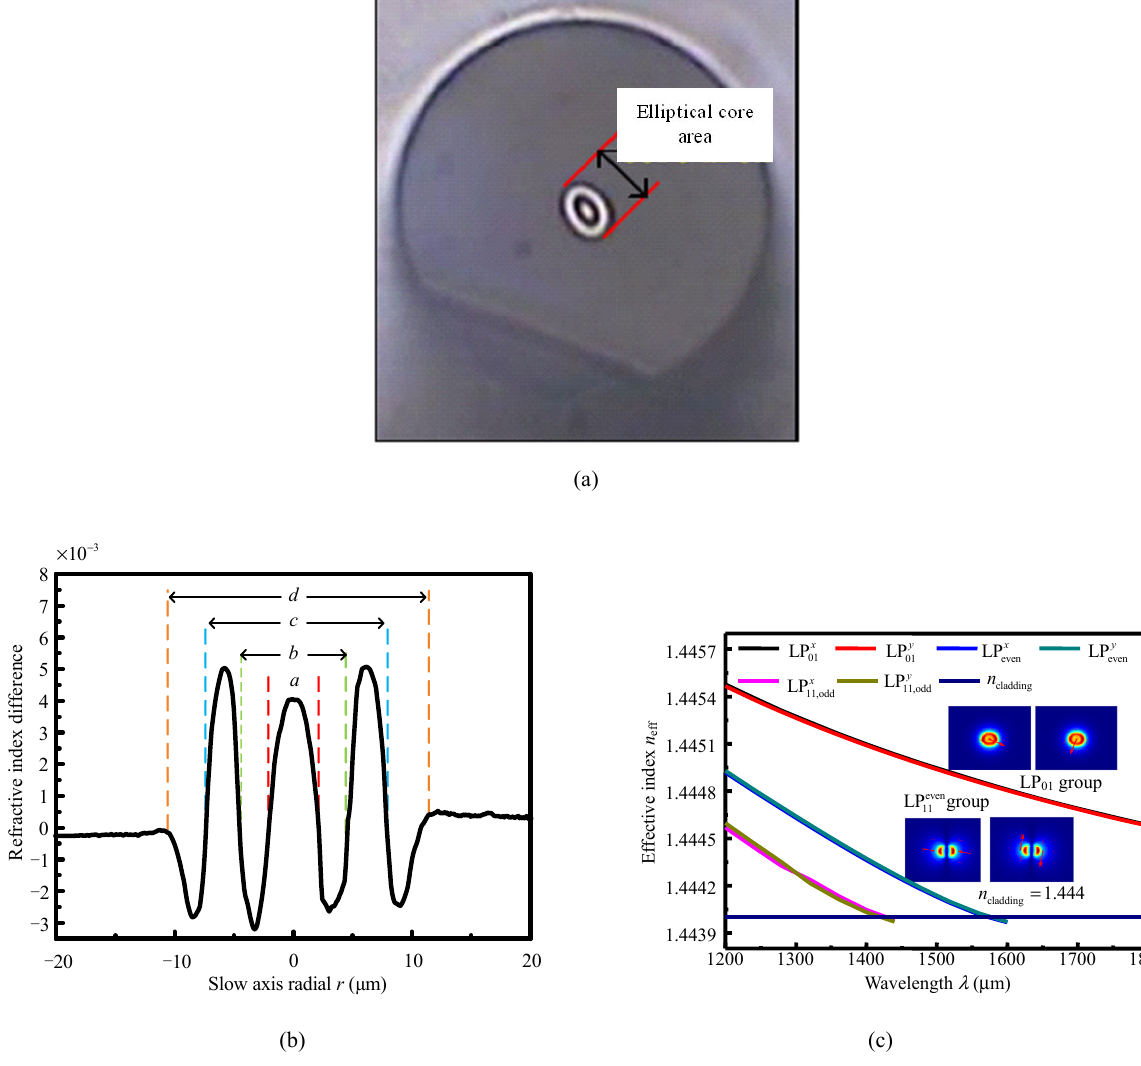
Fig. 1 Schematics of (a) cross-section view, (b) refractive index distribution of the CMECF, and (c) curves of λ vs. n eff of the guided